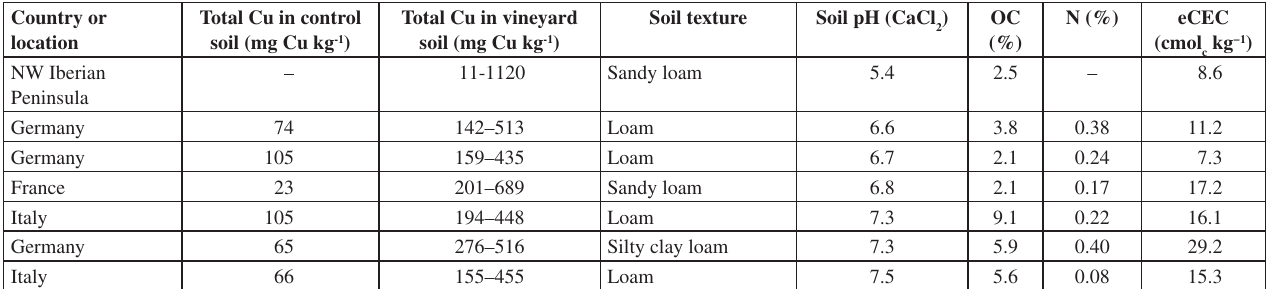
kg −1 ) on soil total c